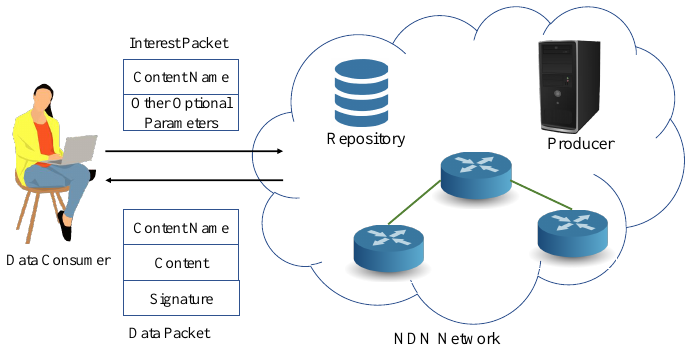
Figure 11. Data fetching in NDN network.